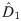
Distance contrast D^1 between the stochastic blockmodel and the uncorrelated random graph model (null model).